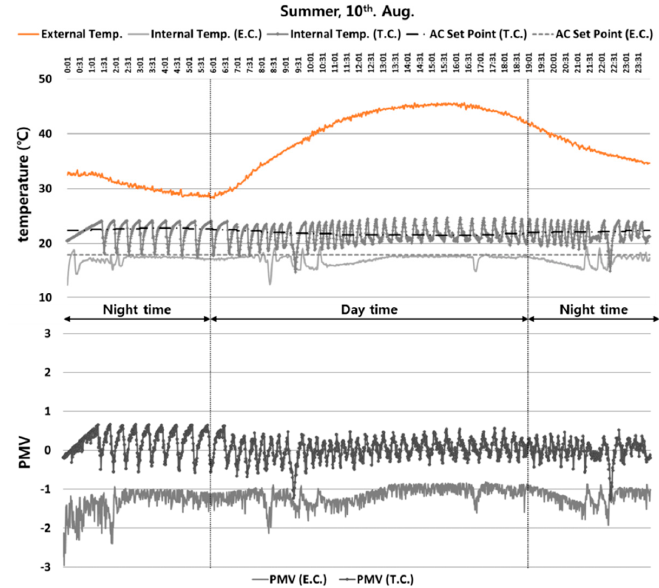
Figure 19. Experimental results recorded on August 10.